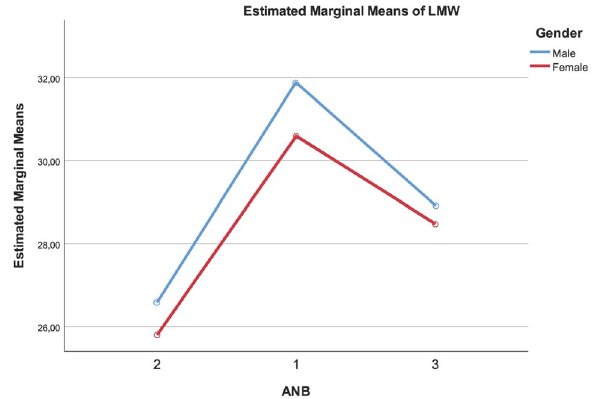
Figure 5. The plot of the mean LMW measurements for each combination of groups of Gender and ANB are plotted in a line graph.